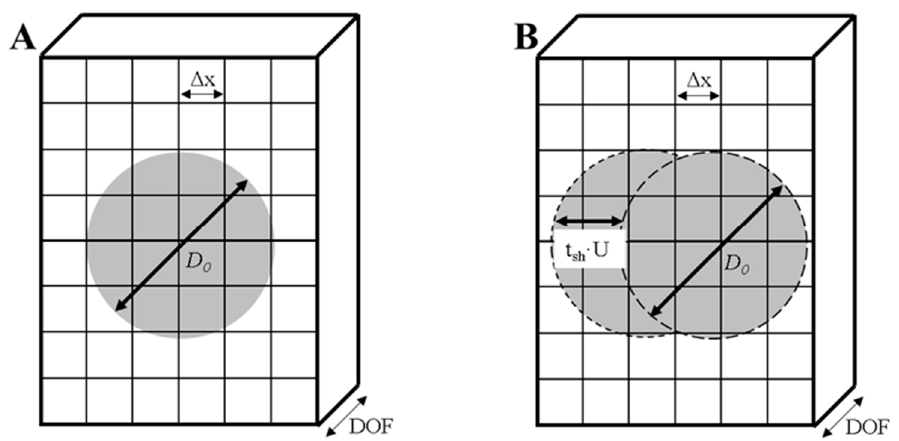
Figure 6. ( A ) Illustrating the depth of field (DOF). ( B ) Illustrating how the images will become artificially elongated if the product of the shutter time ( t sh ) and drop velocity ( U ) is large in comparison to the drop diameter ( D 0 ) or in comparison to the image resolution ( Δ x) .